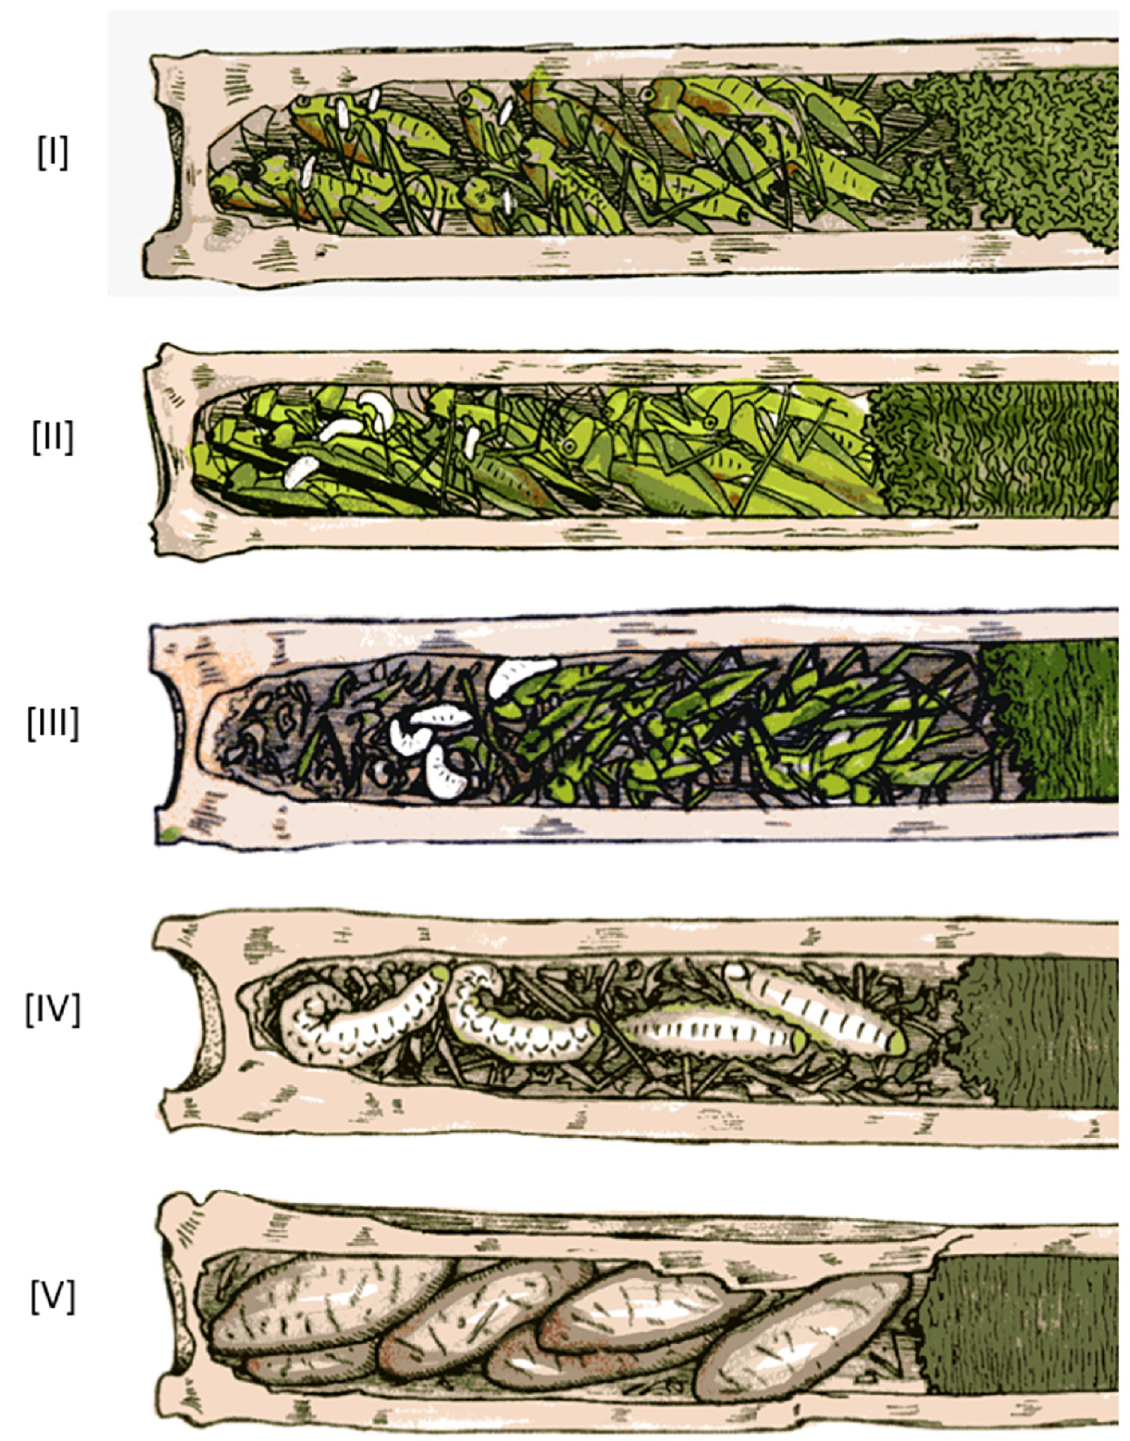
Fig 1. Illustrative presentation of different developmental stages of brood in Isodontia harmandi nest. Developmental stage [I], eggs, which are singly laid on each prey by female wasp; [II], hatchlings, which emerged and begin to consume their own prey; [III], middle-sized larvae, which move around and consume one and another prey in the brood cell; [IV], full-grown larvae have consumed almost all prey; and [V], almost all larvae spun their own cocoons.